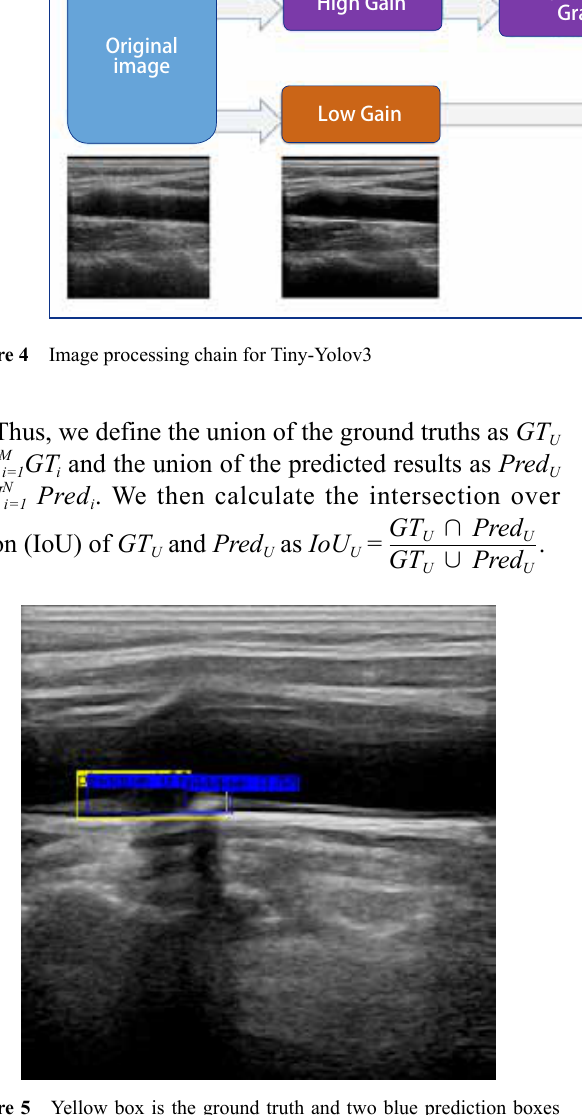
Figure 5 Yellow box is the ground truth and two blue prediction boxes correspond to a hypoechoic soft region and a hyperechoic hard region of the plaque. We first find the union of the predicted results and then compute the IoU using this union